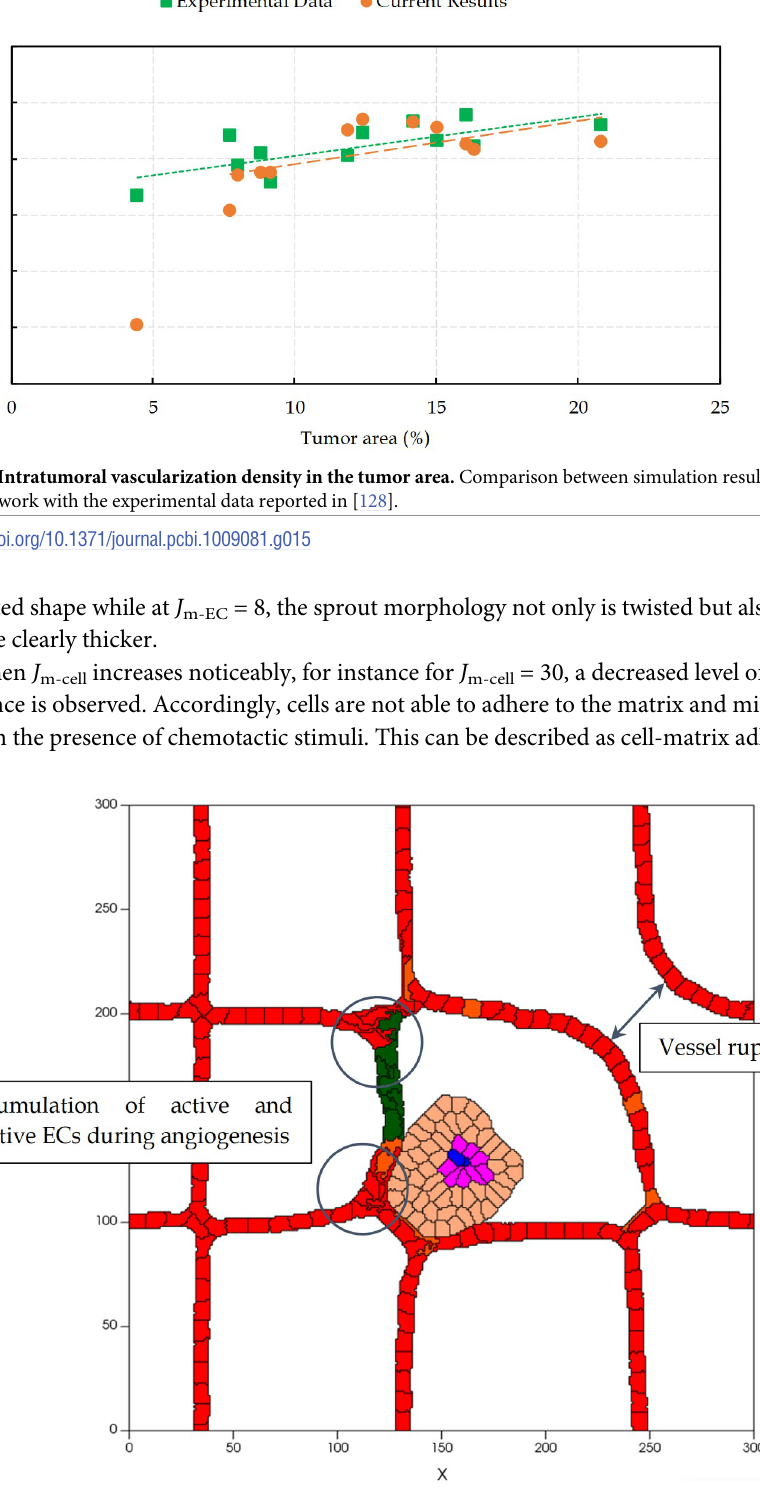
Fig 16. Structure of vascular network for low values of J EC-EC , on day 7, which leads to an accumulation of active and inactive ECs during angiogenesis and to vessel